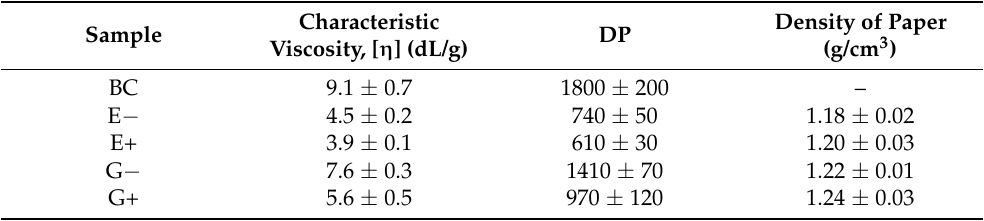
Table 1. Characteristic viscosity and degree of polymerization (DP) of the initial BC and BC after DES treatment.